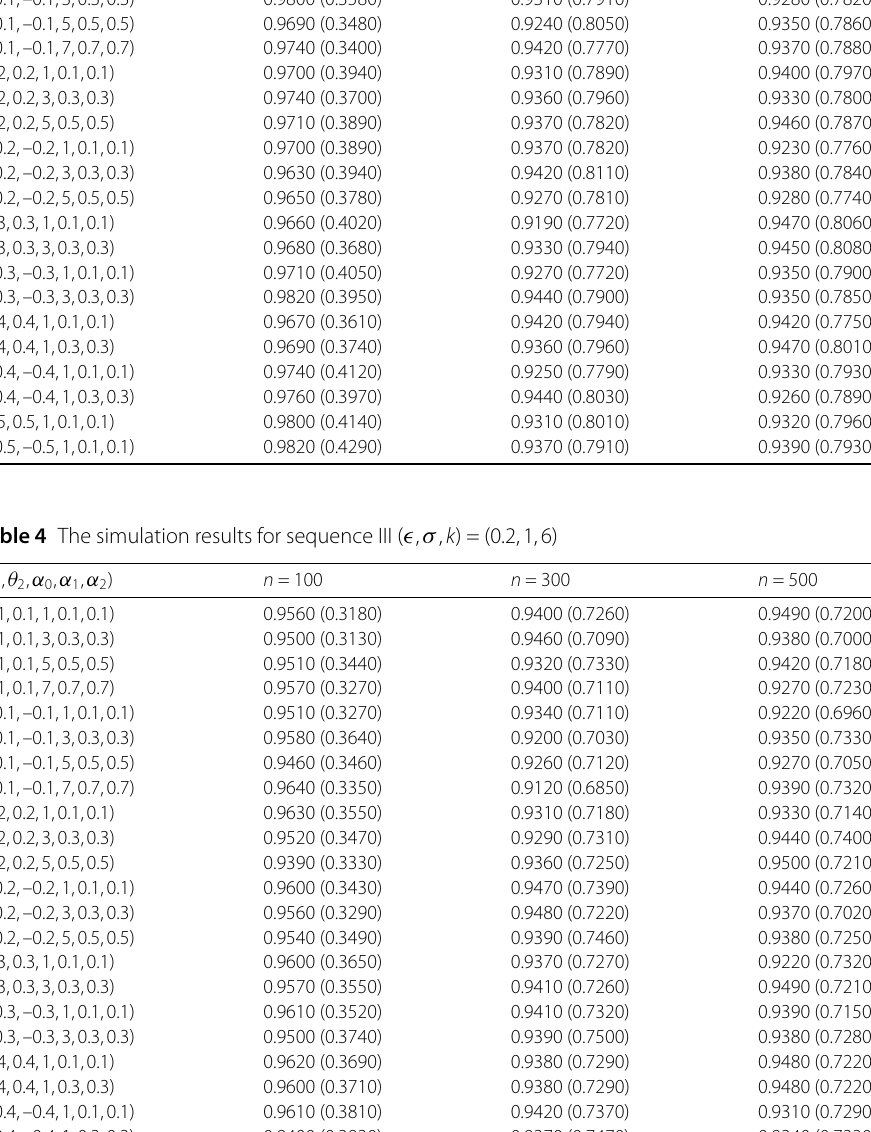
Table 3 The simulation results for sequence II ( (cid:9) , σ 1 , σ 2 ) = (0.75,1, ( θ 1 , θ 2 , α 0 , α 1 , α 2 ) n = 100 n = 300 (0.1,0.1,1,0.1,0.1)